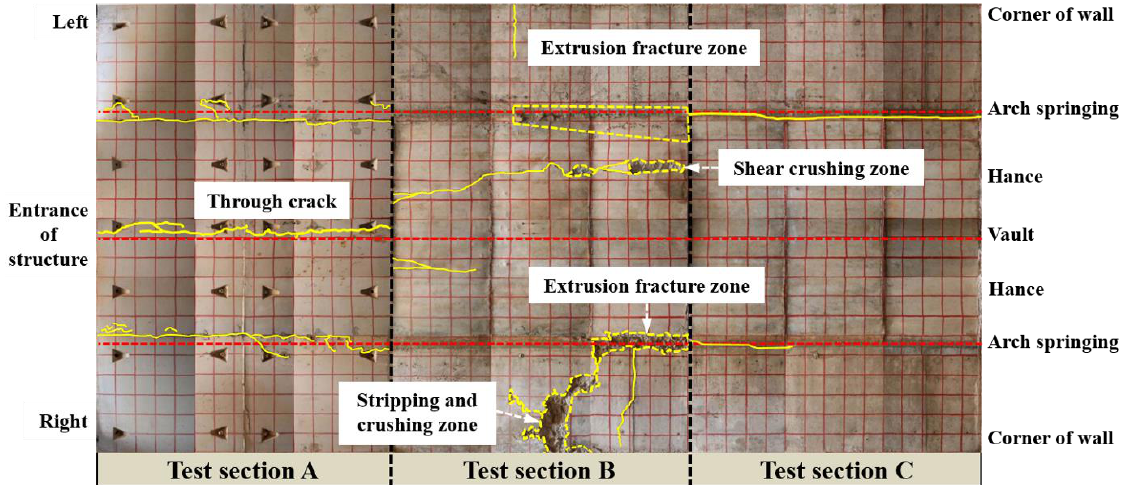
Figure 8. The expanded photograph of the arch and straight wall of the test sections after explosion. ter enduring the explosion load is shown in Figure 9a. The width of the crack in the middle of the vault is about 5 mm, and completely connects with the bottom of the ex- plosion cavity. However, the crack in the vault is not a continuous straight line. The crack extends from the prefabricated bolt hole to the vault. The reason is that the tions. Although the bolt hole has been performed in a smooth engineering treatment, the stress concentration phenomenon still occurs. In addition to the influence of the material heterogeneity and inconsistent boundary conditions at the two ends of the test section, the above asymmetrical cracks are formed.